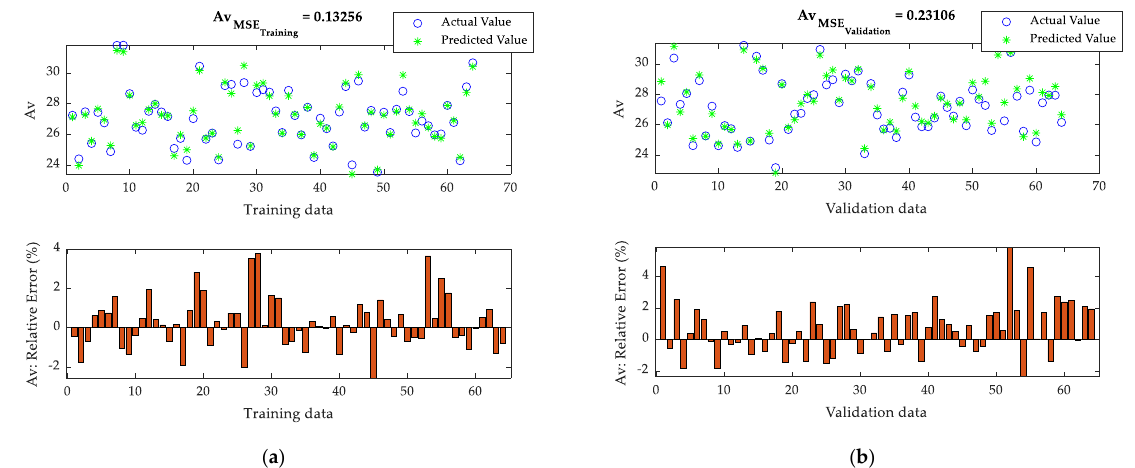
Figure 12. Results obtained with the tuned FIS in the second step for Av: ( a ) training data, ( b ) validation data.